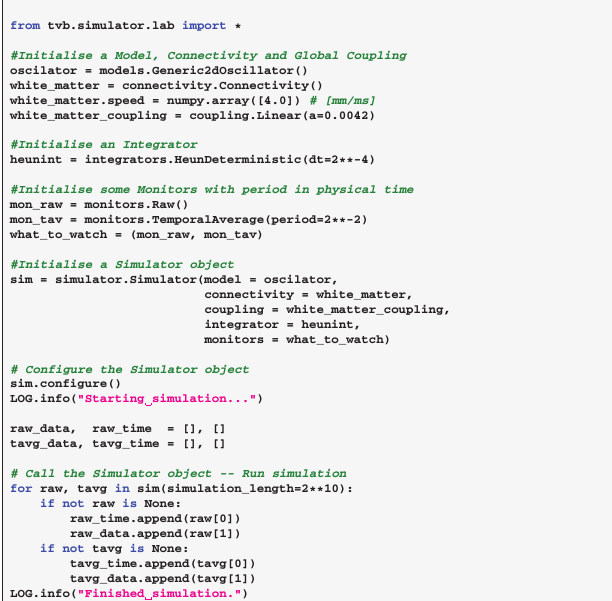
Code 2 | Script example to simulate 1 second of brain activity. Output is recorded with two different